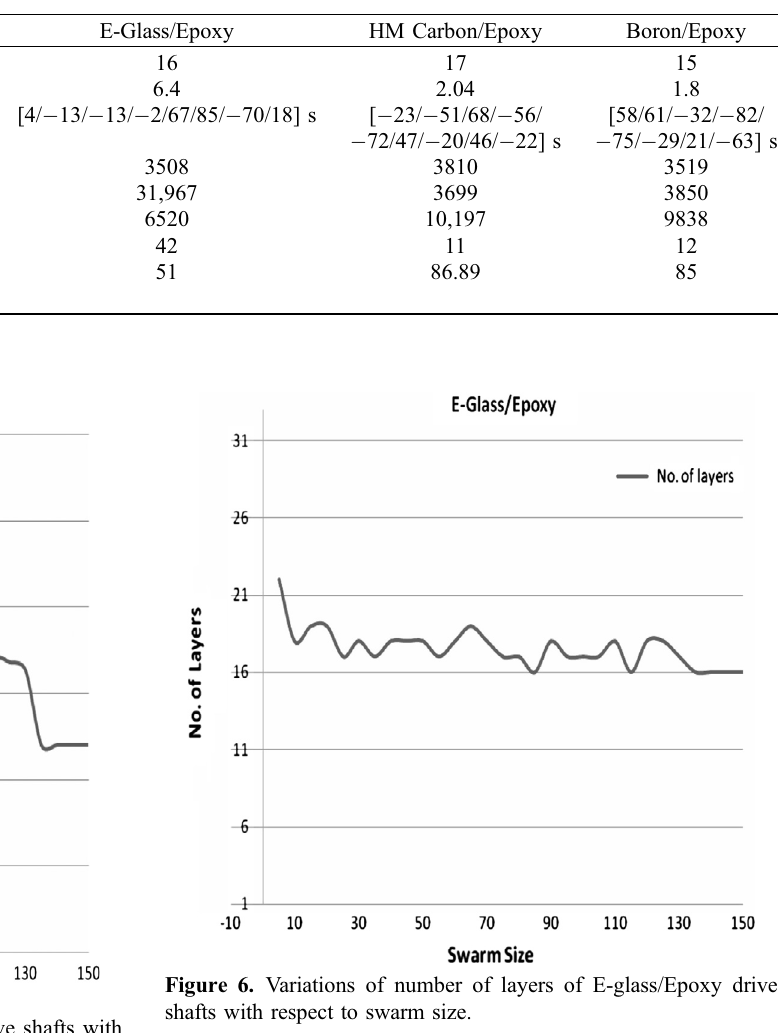
Table 3. Summary of PSOA results.